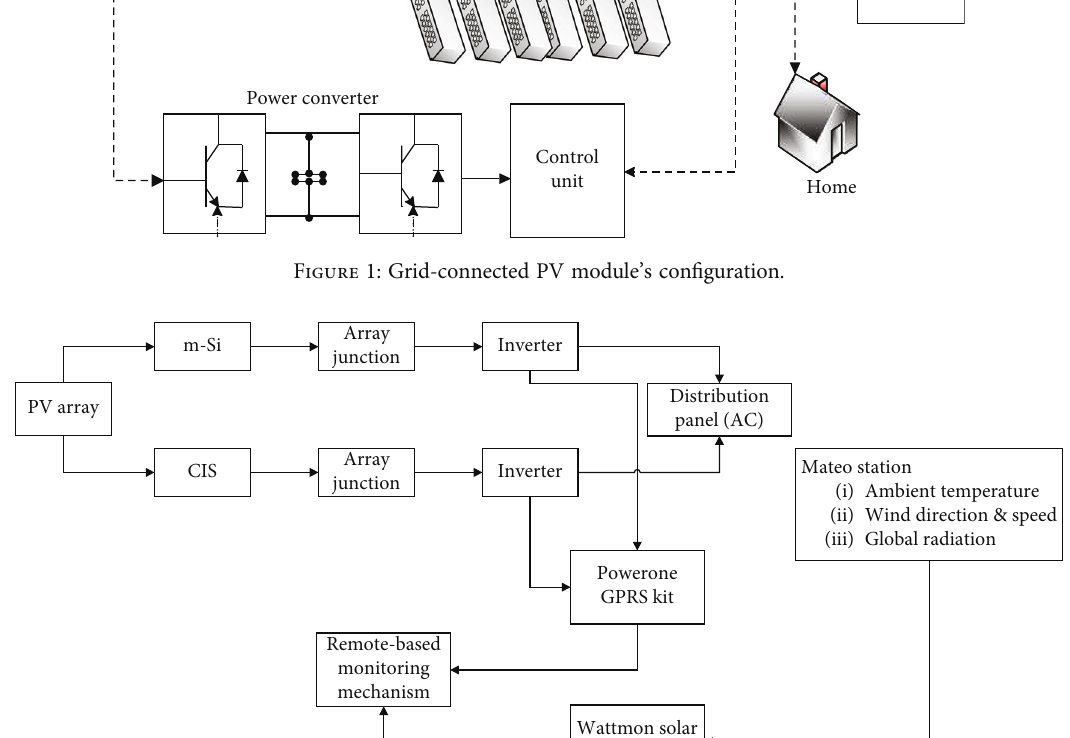
Figure 2: Presented grid-connected PV module ’ s schematic